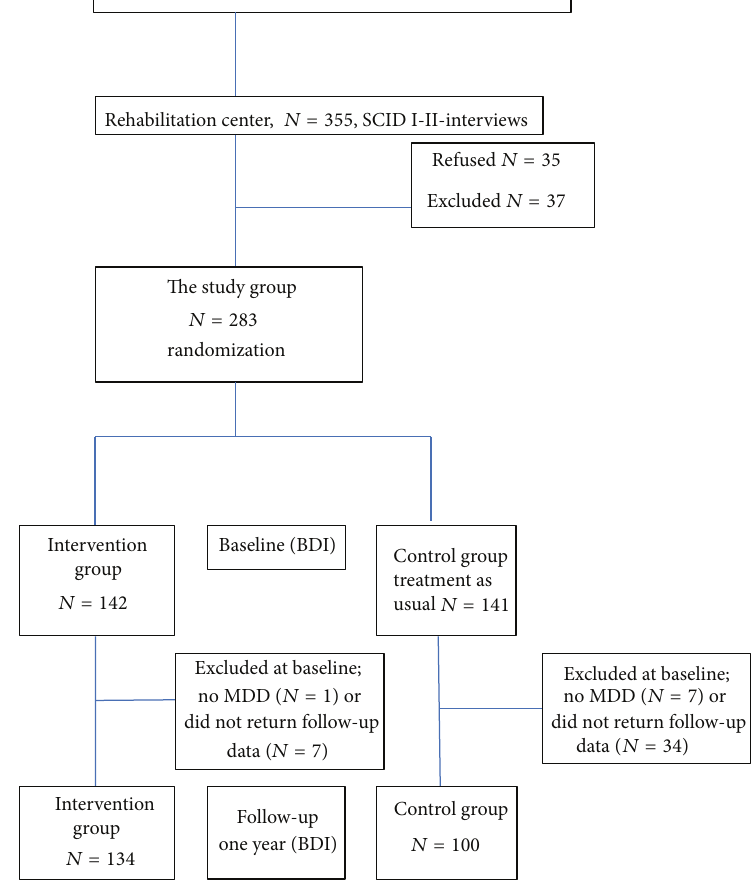
Figure 1: The flow chart of subjects randomized and followed by Beck Depression Inventory